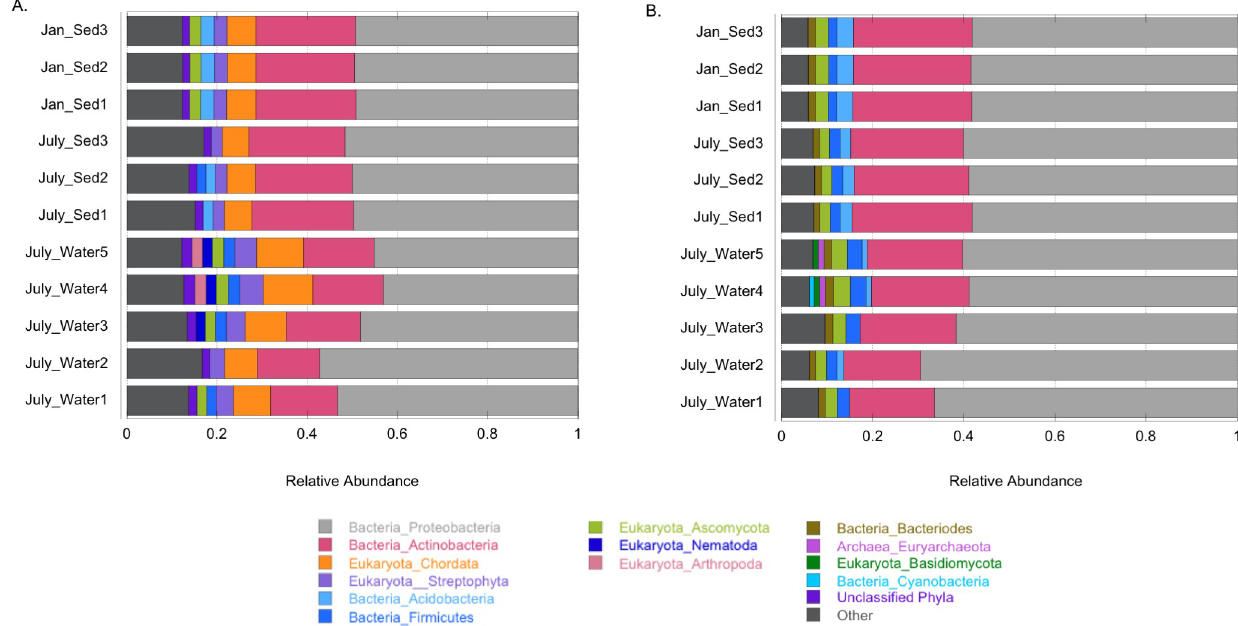
Fig 2. Taxonomic annotation. Seasonal profile of A) all phyla and B) microbial phyla across all samples at EB-90M. Taxa are annotated by superkingdom followed by phylum. “Other” represents phyla that are less than 2% and 1% percent of the data for all organisms and microorganisms,